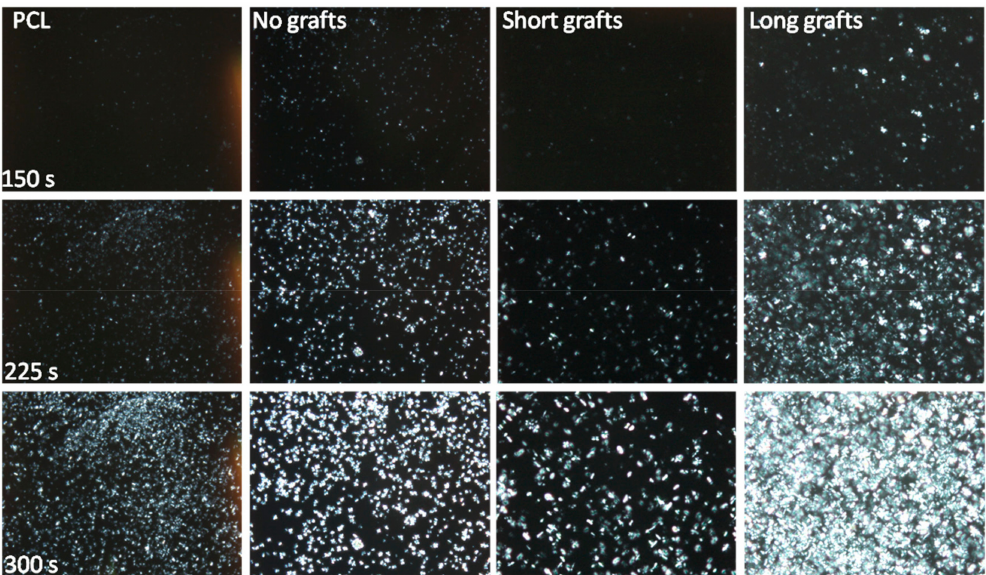
Figure 8. POM images of isothermal crystallisation at 45 ◦ C for di ff erent PCL / silica composites based on the PCL40 matrix and 1 wt% filler.